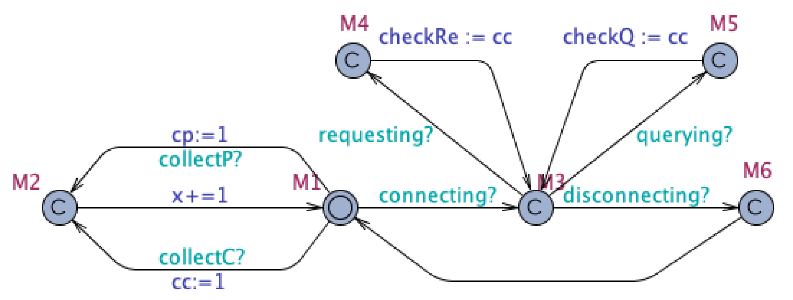
Figure 5. The miner